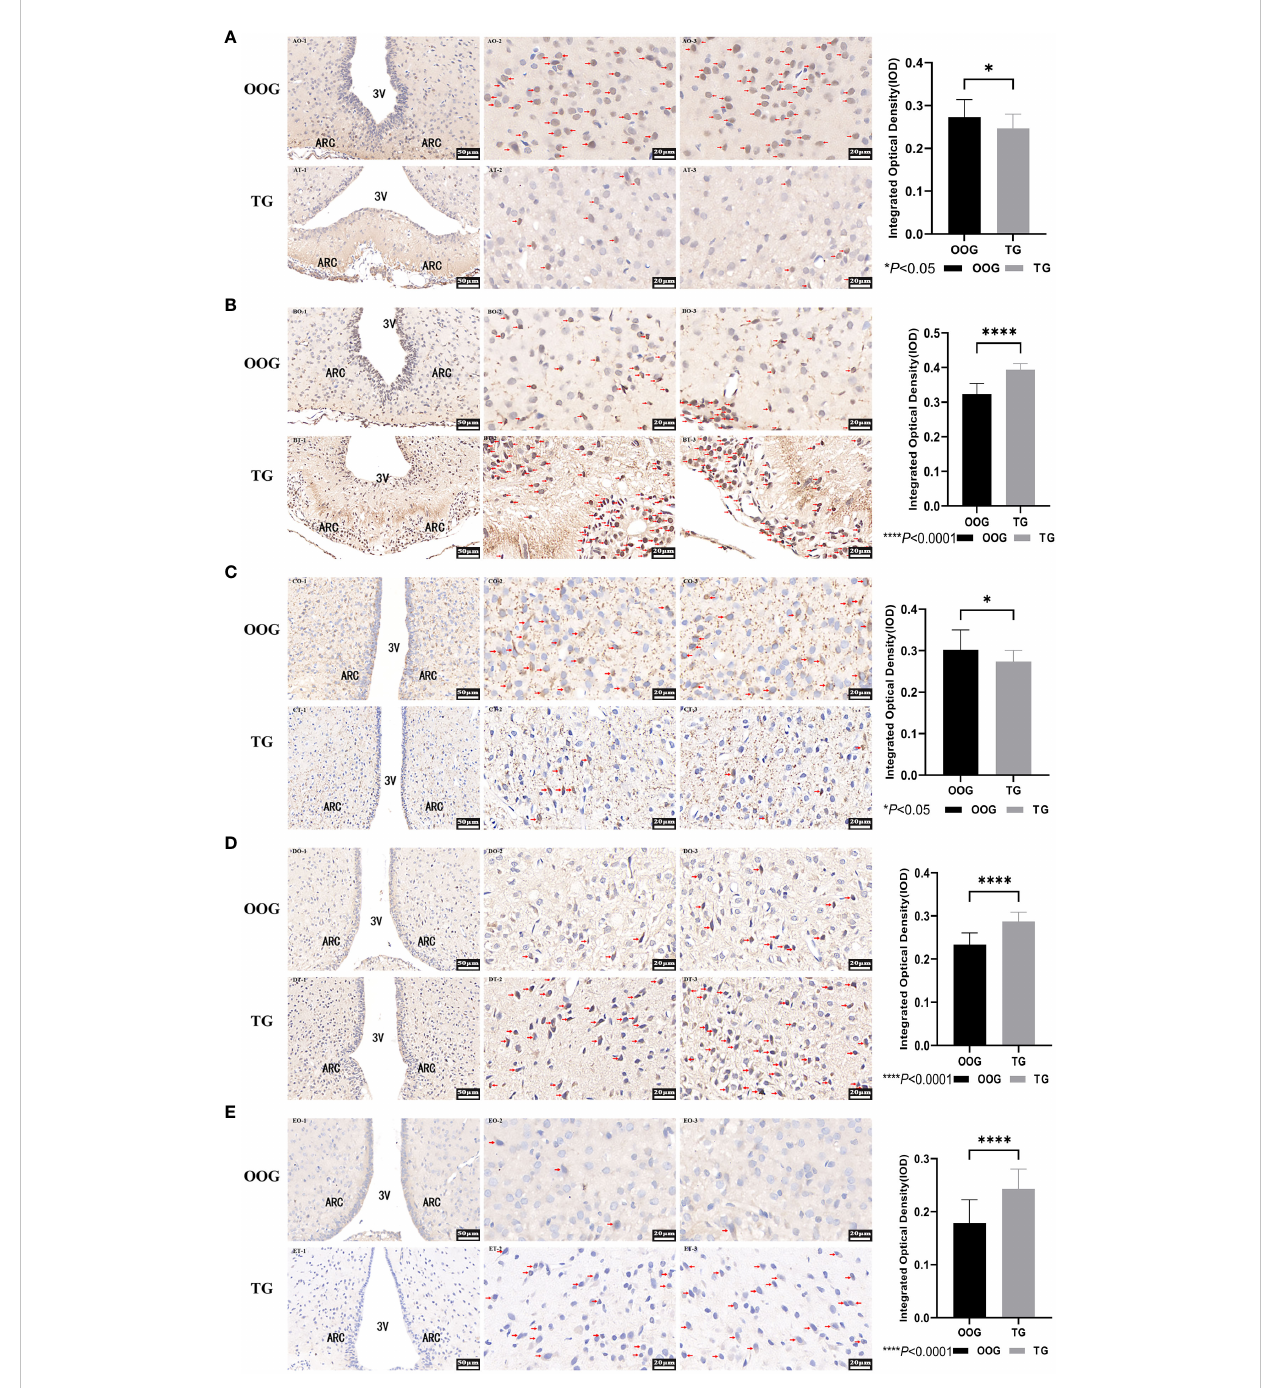
FIGURE 2 Protein expression of AR, ER a , NPY, NPY2R, and LeptinR in the hypothalamus. (A) , the immunohistochemical slice of AR; (B) , the immunohistochemical slice of ER a ; (C) , the immunohistochemical slice of NPY; (D) , the immunohistochemical slice of NPY2R; (E) , the immunohistochemical slice of LeptinR. *P< 0.05, ****P<